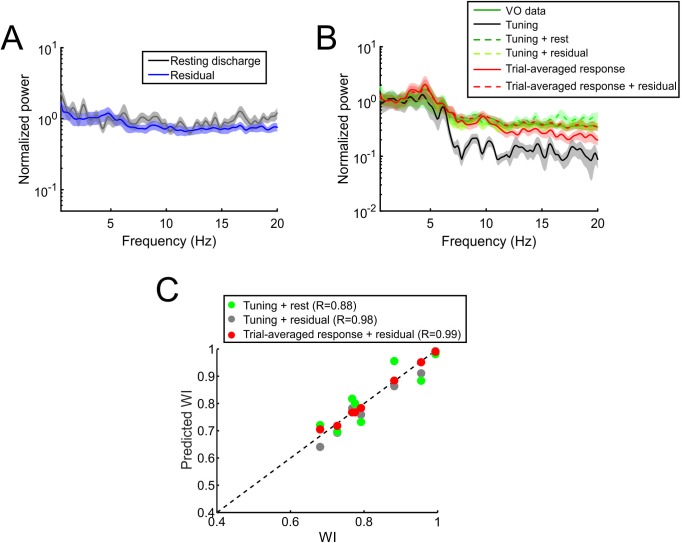
Predicting response power spectra of central vestibular neurons using trial-to-trial variability.(A) Population-averaged resting discharge (gray) and trial-to-trial variability (i.e., the ‘residual’; blue). (B) Population-averaged power spectra of the neural response (green) together with those predicted from tuning alone (black), tuning with resting discharge (dashed green), tuning with trial-to-trial variability (dashed light green). Also shown are the trial-averaged response power spectrum (red) and response power predicted from the trial-averaged response and trial-to-trial variability (dashed red). (C) Predicted vs. actual white index values computed using resting discharge and tuning (green), trial-to-trial variability and tuning (gray), and using trial-to-trial variability and trial-averaged response (red). Bands represent ±1 SEM.